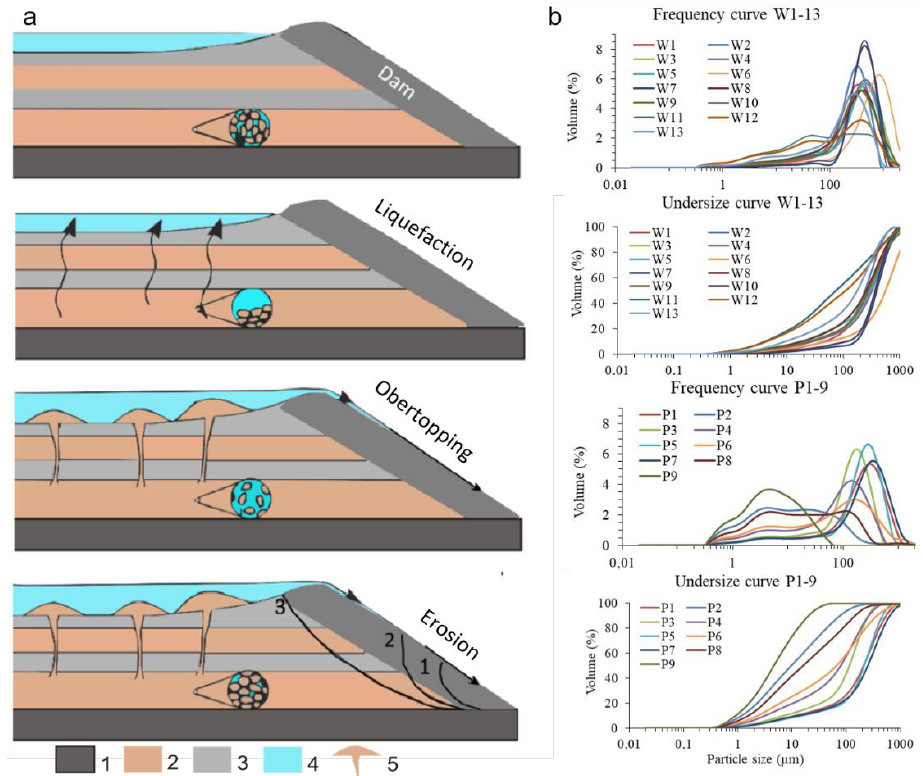
Figure 12. ( a ) Conceptual model of the “El Descargador” tailings dam flow failure. The model proposes a history of static liquefaction favored by the gain size of tailings at base levels and the rise in the hydraulic head by the effective groundwater recharge from the lagoons (stage 2). The upwelling of sands and water caused the clogging of the lagoons and the freeboards overtopping (stage 3). The flowing of tailings and water on the slopes together with the internal erosion and the pore-fluid over pressuring of the tailings mass triggered the land sliding (stage 4). 1. Basement; 2. Sandy tailings layers; 3. Silty tailings layers; 4. Water and 5. Sand dikes and volcanoes. ( b ) Textural features of mine tailings: samples P1 to P9, collected from the trial-pit profile and W1 to W11, collected from the sand dike from bottom to top on the surface of landslide four (see Figure 4 and Table S2).